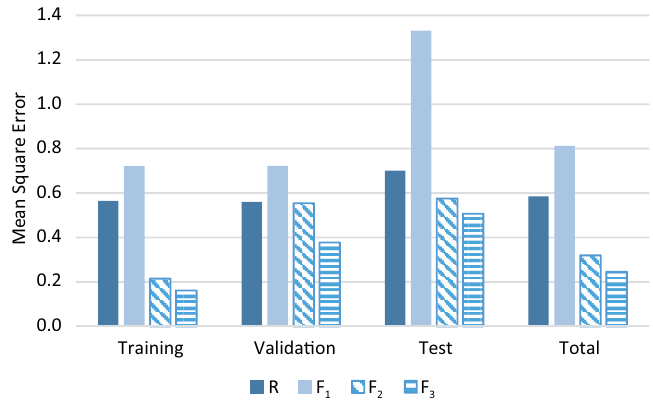
Figure 6. Mean Square Error for R, F 1 , F 2 , F 3